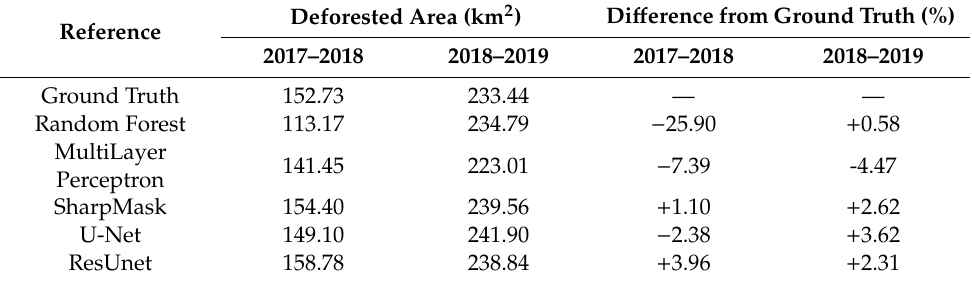
Table 5. Total deforested area according to the ground truth and each model’s